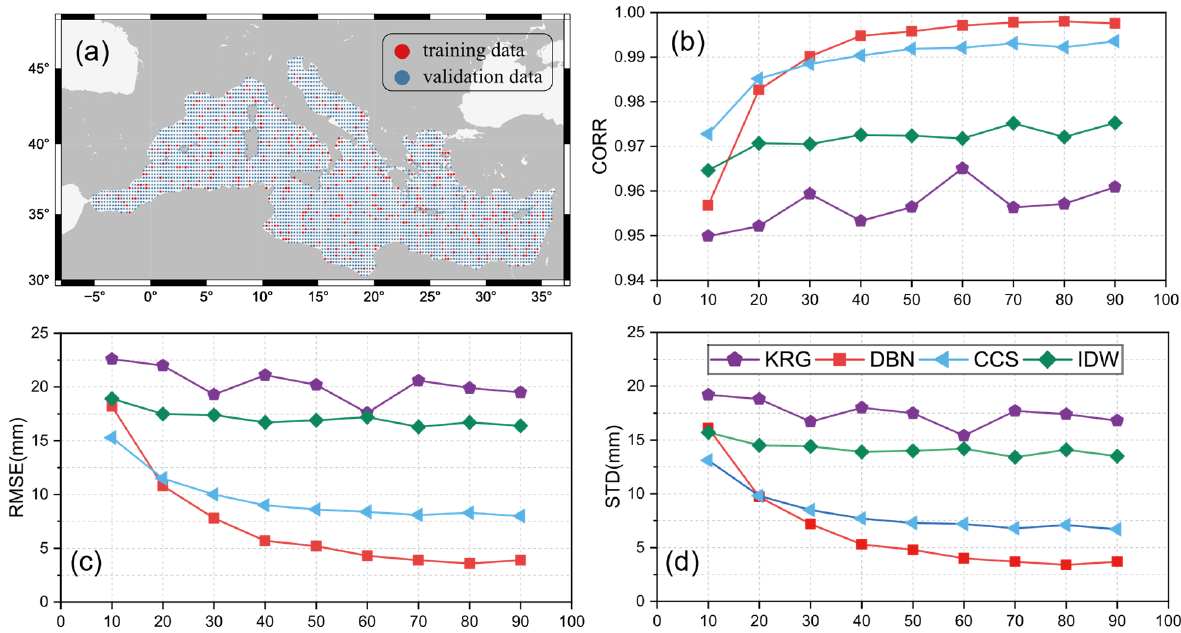
Figure 3. The distribution of training data (red) and validation data (blue) without tide gauges ( a ), and the correlation coefficients ( b ), RMSE ( c ) and STD ( d ) for four methods. The horizontal coordinates of ( b – d ) are percentages of gridded SLAs (%).